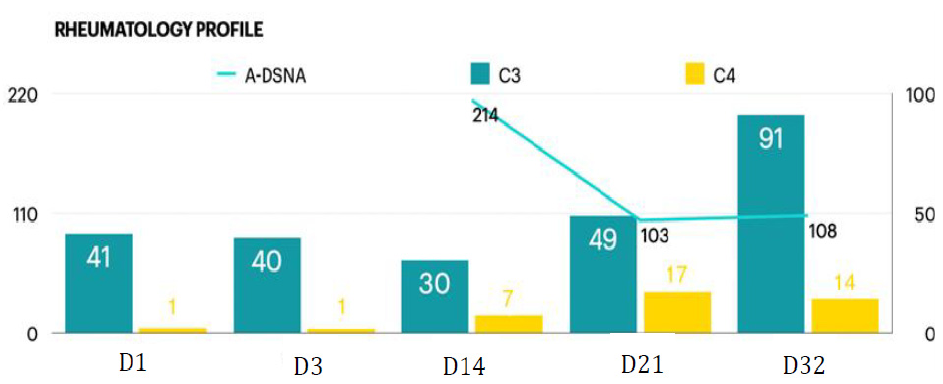
Figure 2. Rheumatology profile during the course.